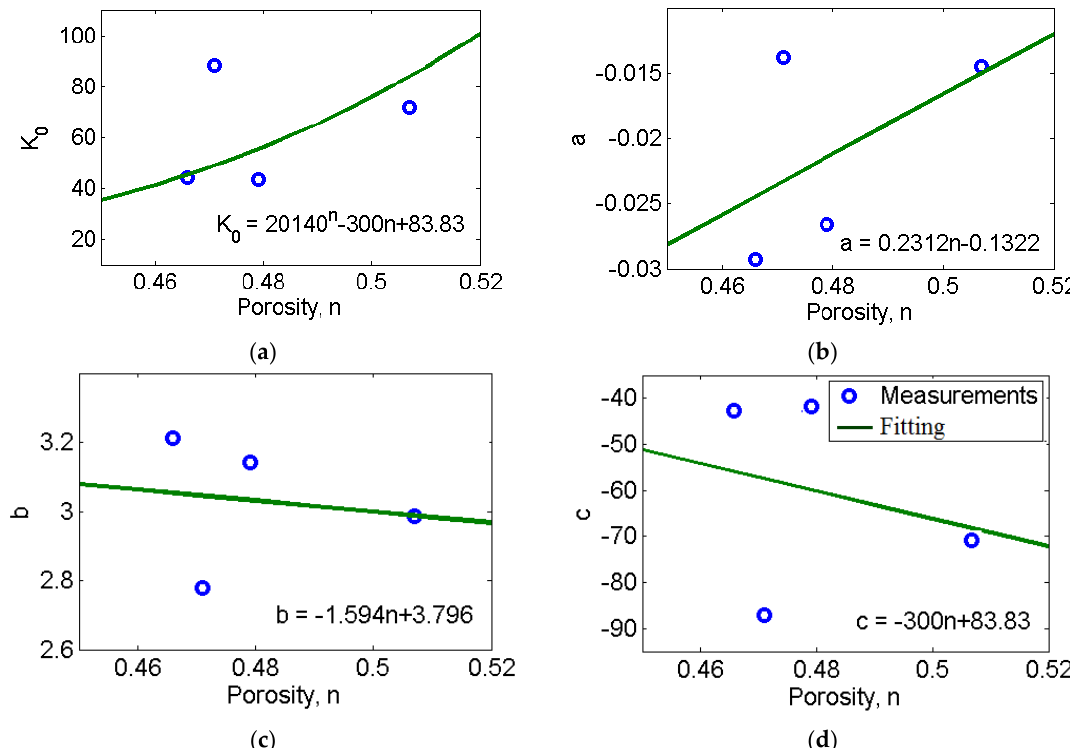
Figure 9. The Fitting Result of the Parametric Functions, ( a ) Equation (7b); ( b ) Equation (7c); ( c ) Equation (7d); ( d ) Equation (7e).